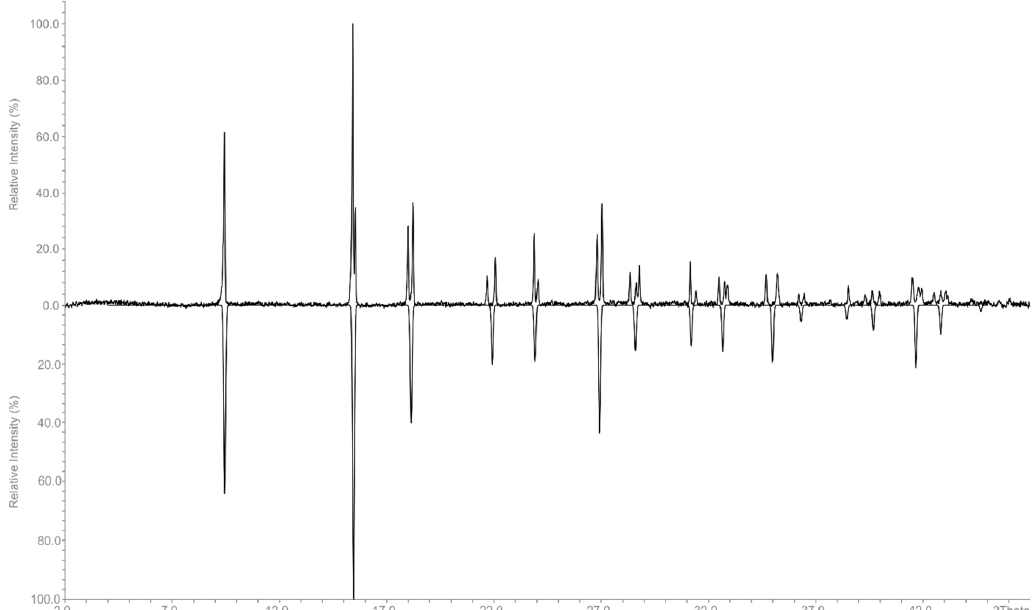
Figure 2. Powder X-ray diffraction pattern of NaTl produced by melting the elements and quenching the reaction (Mo radiation ( λ = 0.70926 Å (Mo-K α 1 )) yields a smaller 2 θ range compared to Cu radiation ( λ = 1.540598 Å (Cu-K α 1 )), which is typically used). Downwards, Zintl’s cubic NaTl is given for comparison.